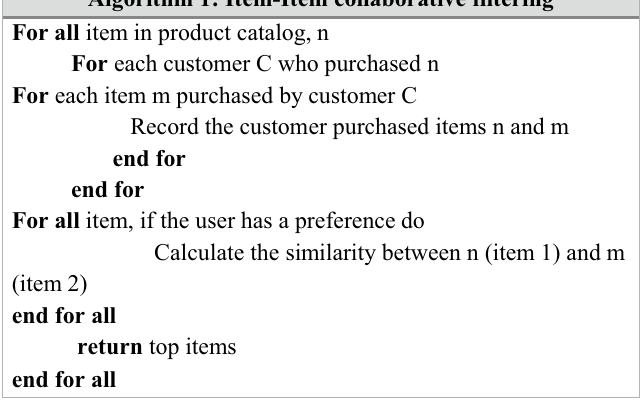
Algorithm 1: Item-Item collaborative